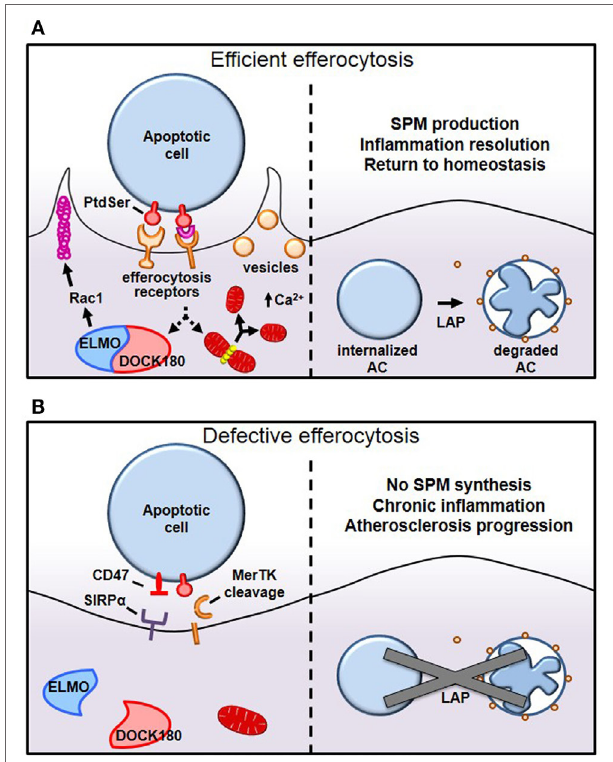
FiGURe 1 | Mechanisms of efferocytosis. (A) Macrophages interact with phosphatidylserine (PtdSer) externalized on apoptotic cells either directly or indirectly, through bridging molecules. Many PtdSer receptors stimulate ELMO–DOCK180 interactions to activate Rac1 and polymerize actin around the phagosome. Simultaneously, macrophages trigger Drp1-mediated mitochondrial fission to drive calcium-dependent vesicular trafficking. Once internalized, autophagic machinery is used to conjugate lipids to LC3 bound to phagosomes, which drives phagolysosomal fusion and subsequent apoptotic cell degradation. (B) In pathological settings such as advanced atherosclerosis, one or more of these processes can become defective, leading to inefficient clearance of apoptotic cells and subsequent necrosis and inflammation. For example, in advanced atherosclerosis, apoptotic cells can inappropriately express the “don’t eat-me” signal CD47, or cell-surface receptors can get proteolytically cleaved, such as with